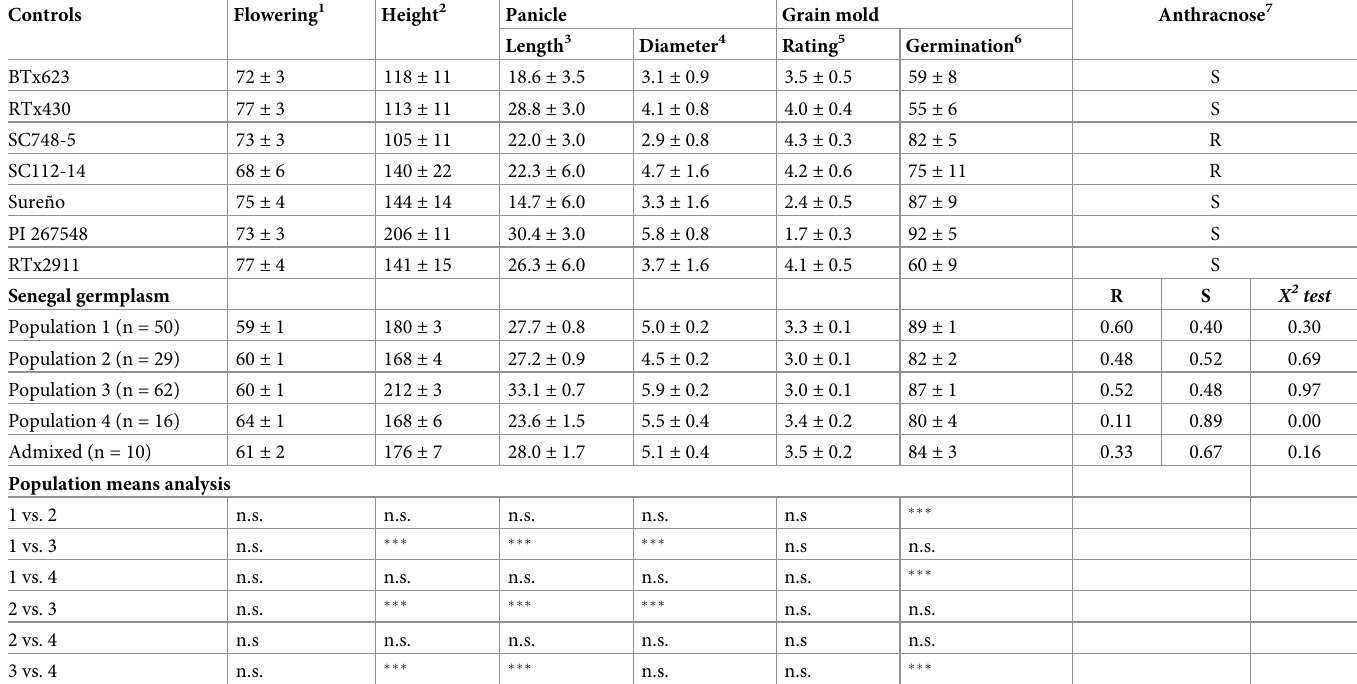
Table 3. Phenotype analysis of NPGS Senegal sorghum germplasm populations.